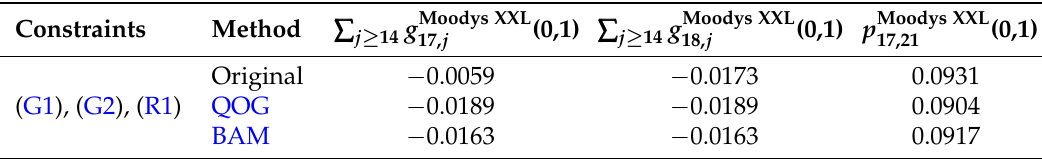
Table 6. Corrections of the additional Constraint (R1) and its impact on the default probabilities of QOG and BAM, for transition matrix P Moodys XXL ( 0,1 ) in Table